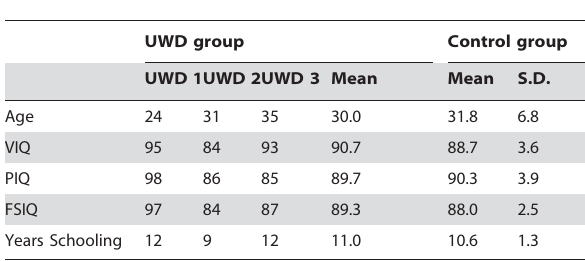
Table 2. Age, schooling, and Wechsler Abbreviated Scale of Intelligence for each UWD subject and controls.